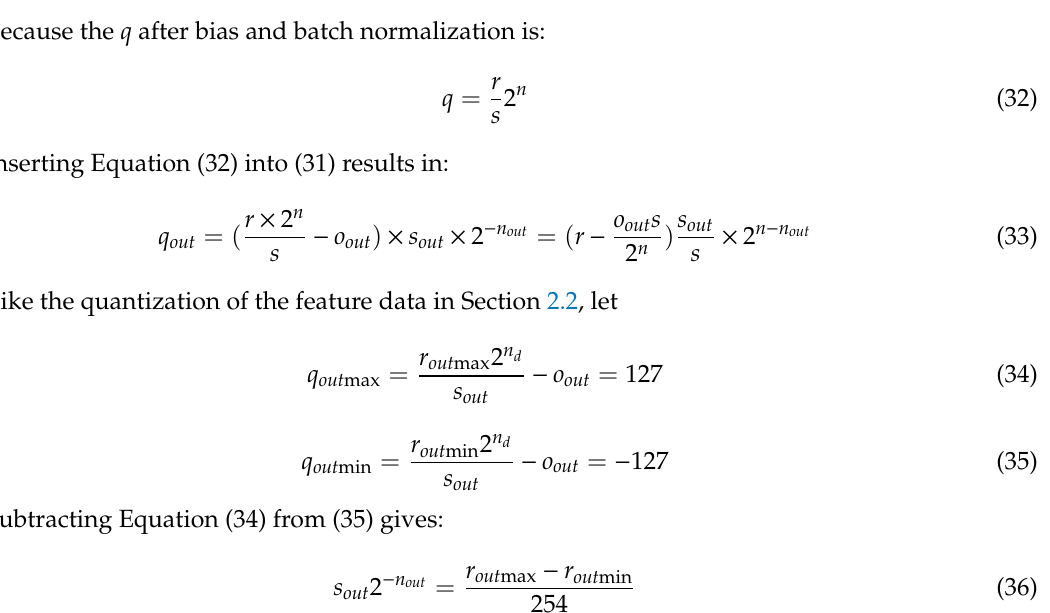
Figure 2. Quantization operation unit structure diagram. The workflow of the quantized CNN acceleration circuit is as follows. The quantization parameters of all modules were stored in the configuration register unit. After the Feature_data and weight were input, the feature_quantizatier and weight_quantizatier quantized the feature data and weight into 8 bit. The MAC_array and accumulation unit (ACCU) completed the convolution operation and the result became 32 bit. Since the quantization parameters of each kernel cube array were different, after each kernel convolution operation was completed, all the different quantization parameters of all kernel cube arrays needed to be unified by Unify_quantizatier. The bias and bn operations were completed by the quantize adder and multiplier, and the value became 41 bit. Then, the activation operation was completed through the ReLU unit. The value from the ReLU unit was quantized to 8 bit by the output quantization unit, and then the pooling operation was completed by the pooling_unit. 4. Dual Register Group Structure The classical neural network acceleration operation flow is that a layer requires the computational results of its preceding layer. This dependency is illustrated in Figure 3, indicating how substantial time is lost when waiting for the computation of a layer to finish.